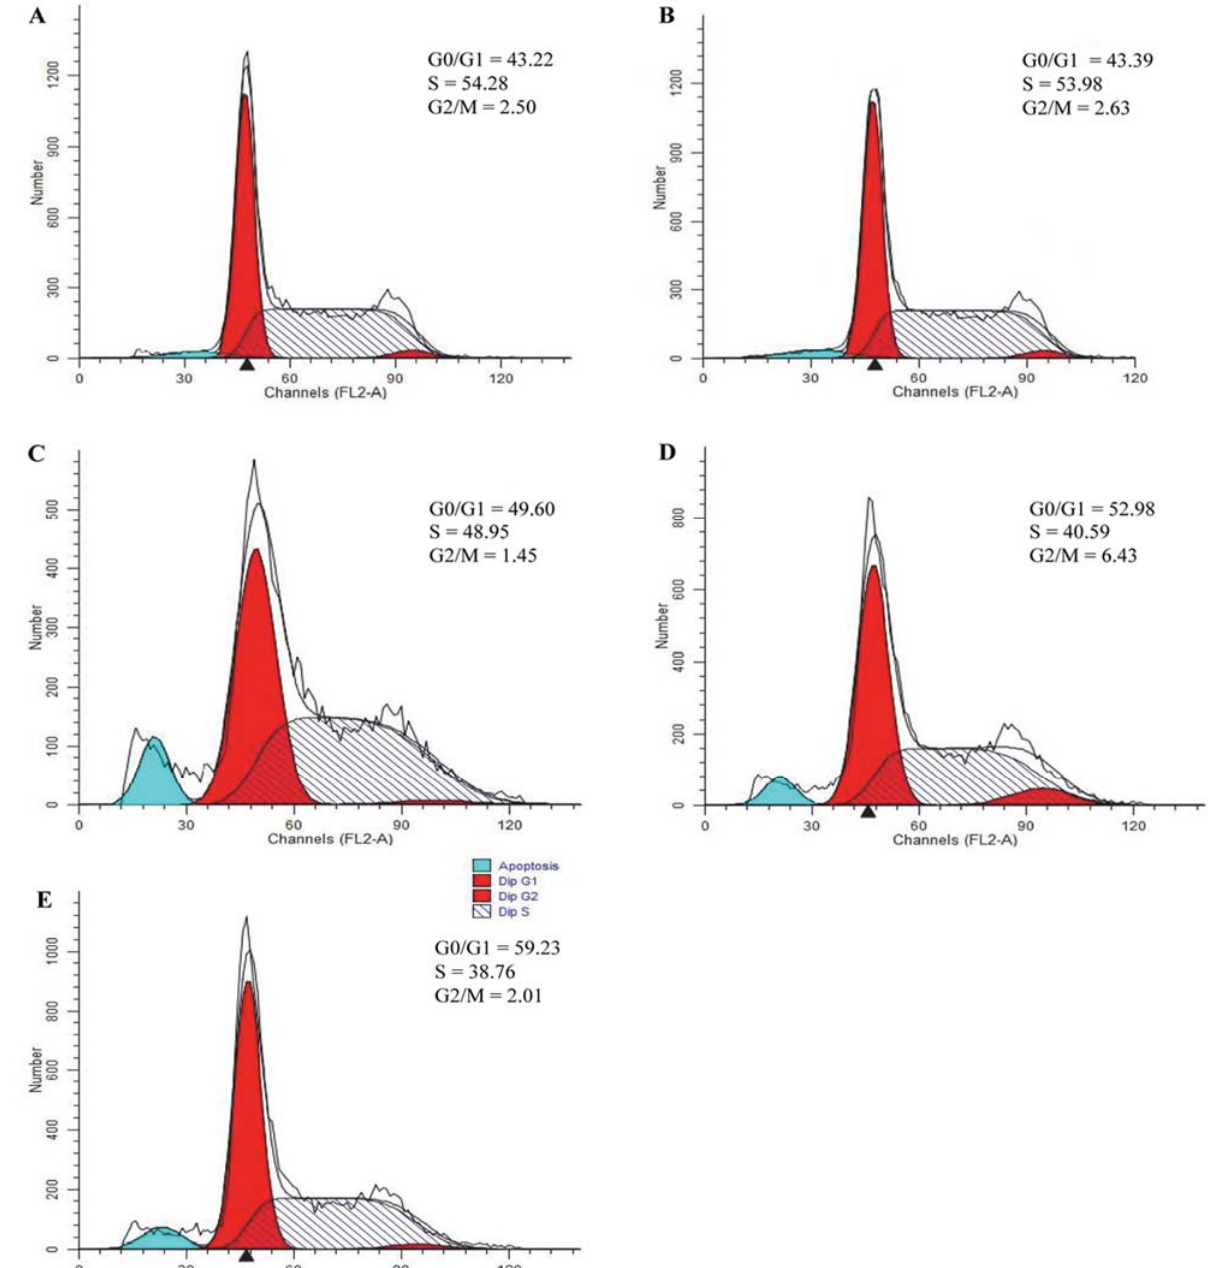
control ( A ); 7.5 μ g/mL triterpenes ( B ); 15 μ g/mL triterpenes ( C ); 30 μ g/mL triterpenes ( D ); positive control CTX (10 μ g/mL) ( E ) for 36 h, and then cell cycle analysis was determined by flow